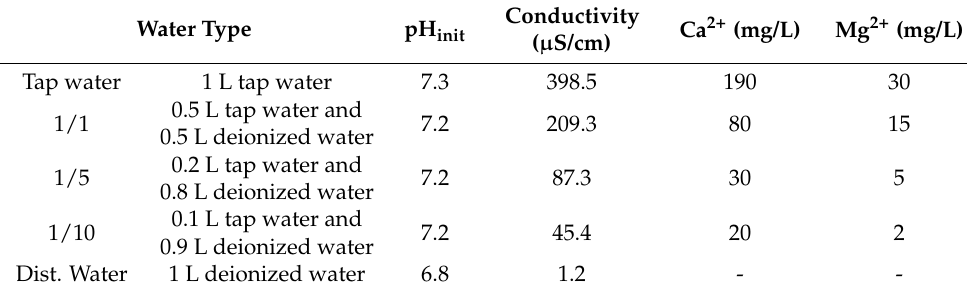
Table 5. Main physicochemical parameters of different water